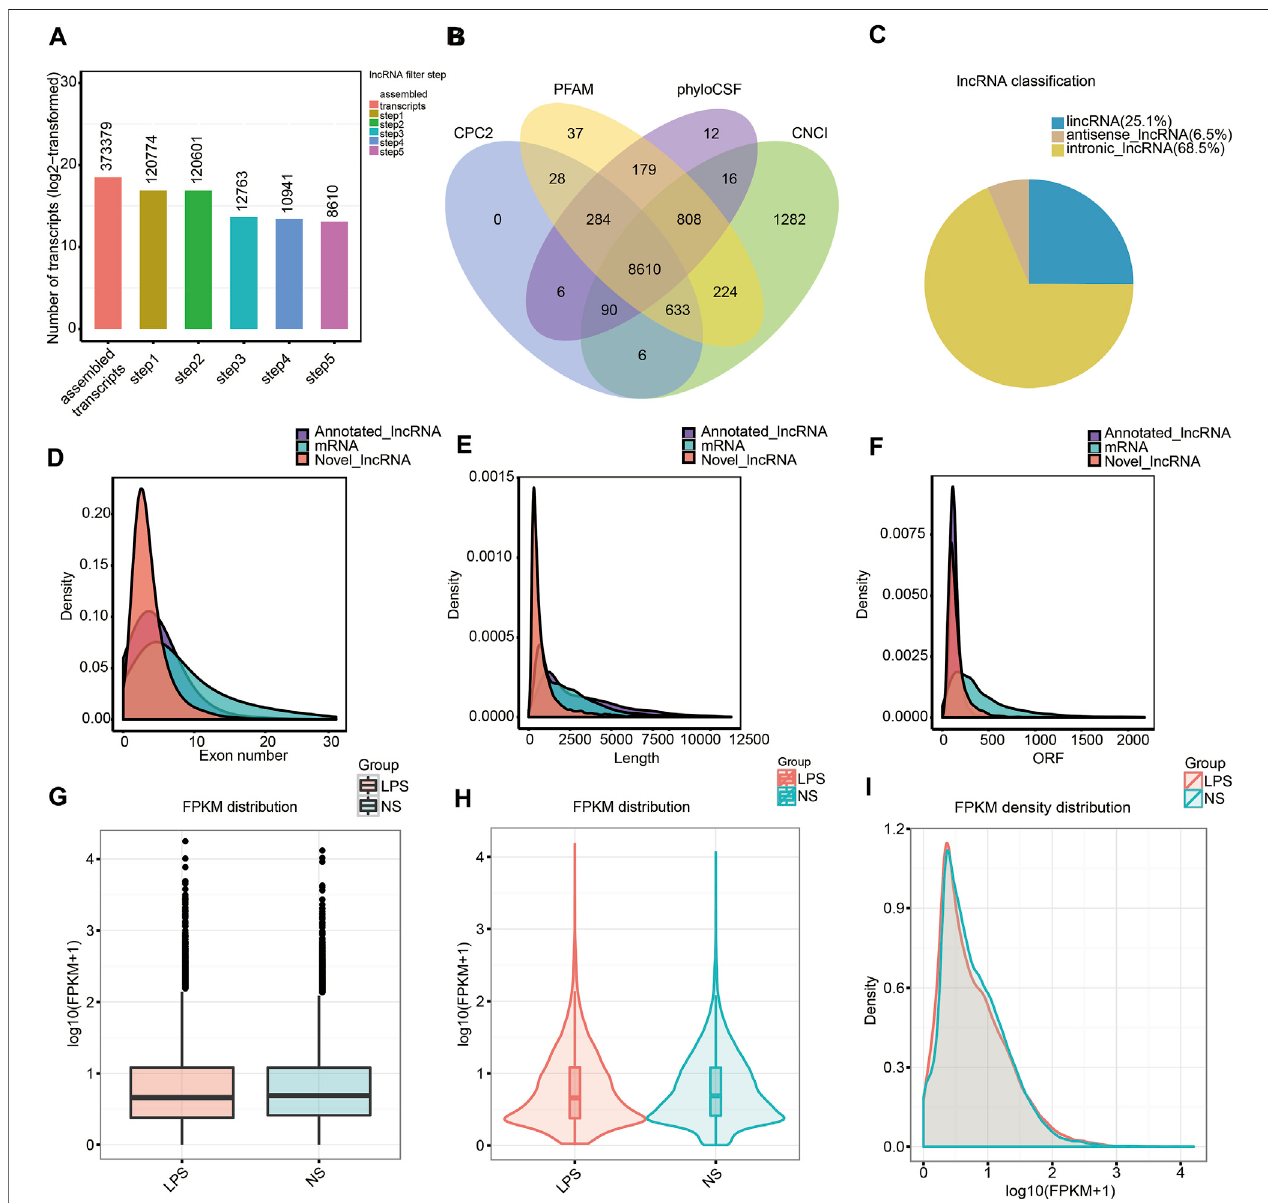
FIGURE 2 | Characterizing lncRNAs along with mRNAs in mouse lung tissue. (A) Screening of new lncRNA in fi ve steps. (B) Coding underlying analysis using CPC2,CNCI,PFAM,andphyloCSF.ThesequencesconcurrentlysharedbytheabovefourtoolswerechosenascandidatelncRNAs. (C) Classi fi cationoftheuncovered lncRNAs. (D – F) Densitydistributionschemeillustrating (D) ttheexpressioncharacteristicsofexonnumber, (E) length,and (F) ORFofannotatedlncRNAs,newlncRNAs, as well as mRNAs in mouse lung tissue. (G – I) Boxplot (G) , violin plot (H) , and density distribution plot (I) revealing the expression characteristics of mouse lung tissue from the ALI group, as well as the control group. LPS, lipopolysaccharide; FPKM, fragments per kilobase of exon per million fragments mapped; NS, no lipopolysaccharide.